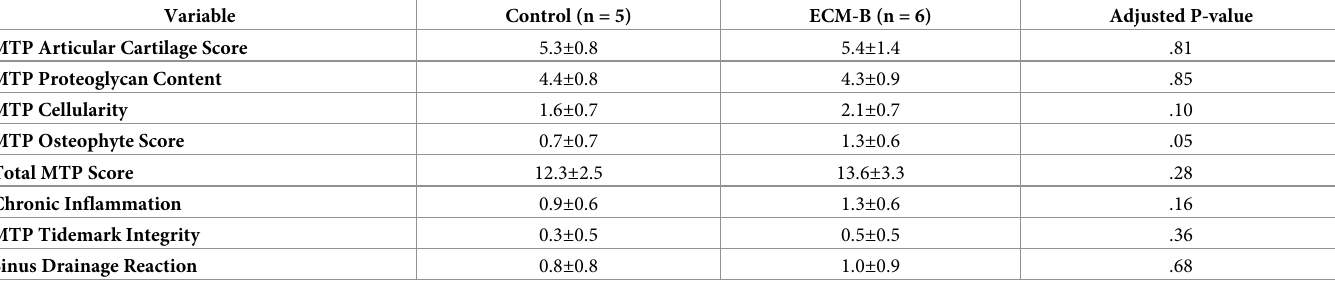
Table 3. Comparison of histology scores between ECM-B and PBS-treated control animals at eight weeks after treatment. Mean scores ± standard error are presented.